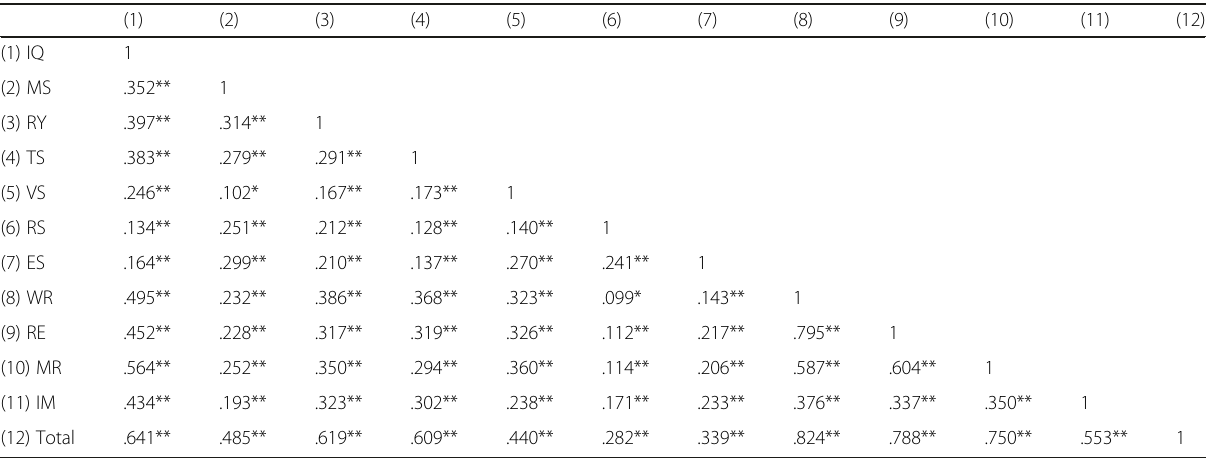
Table 4 Pearson ’ s correlation matrix between total IQ and TLN-C subtests